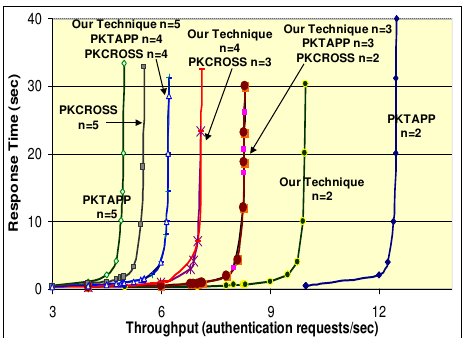
Figure 14. Crossover Numbers vs. Remote